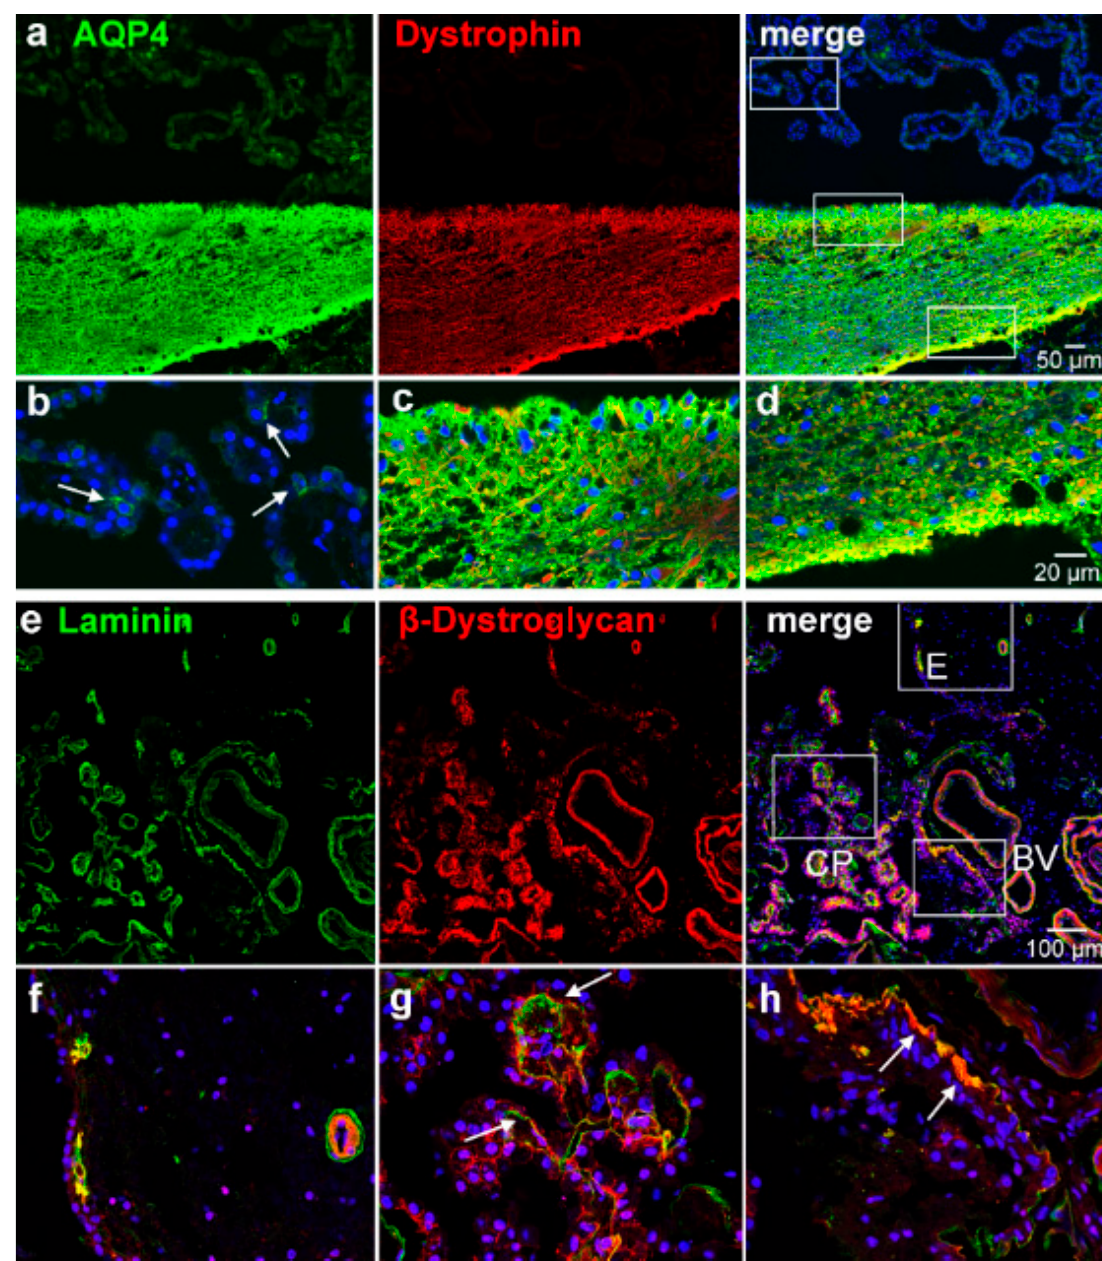
Figure 4. Dystrophin and β -dystroglycan localization in the CP and ependymal transition zone. ( a ) Co-staining with antibodies against AQP4 and dystrophin shows an overlap in the glial subependymal plate but not in the CP. The white rectangles indicate the details shown ( b – d ). ( b ) AQP4-positive cells in the CP (arrows) are negative for dystrophin, whereas ( c , d ) subependymal astrocytic processes were intensely positive for both dystrophin and AQP4. An even stronger immunoreactivity is found on the perivascular side where the processes face a basal lamina than on the ependymal side of the glial plate ( d , c.f., Figures 3b, f). ( e ) β -dystroglycan and laminin co-stainings show a close association of both stains. Detailed views ( f – h ) of the indicated areas reveal that the ependyma as well as astrocytic processes in the glial plate were immunonegative for β -dystroglycan ( f ), except where they contact a basal lamina as indicated by laminin staining. Both stains are also found in and around blood vessel walls ( h ). In the choroid plexus (CP), epithelial cells express β -dystroglycan basolaterally close to the basal lamina ( g